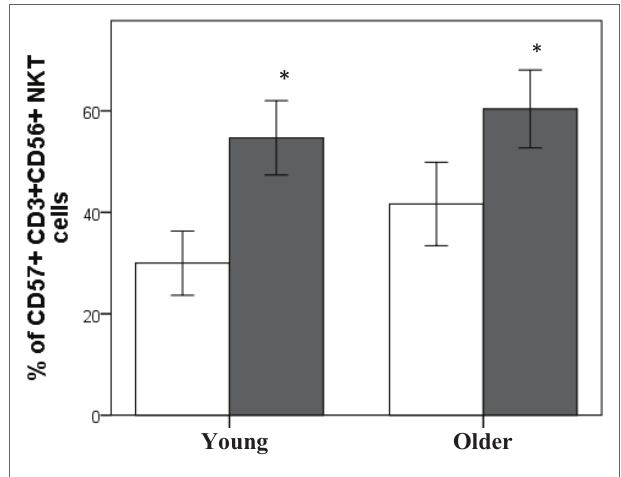
TaBlE 1 | Age-related differences in the natural killer (NK) cell population at baseline. % of immune cells Parent population